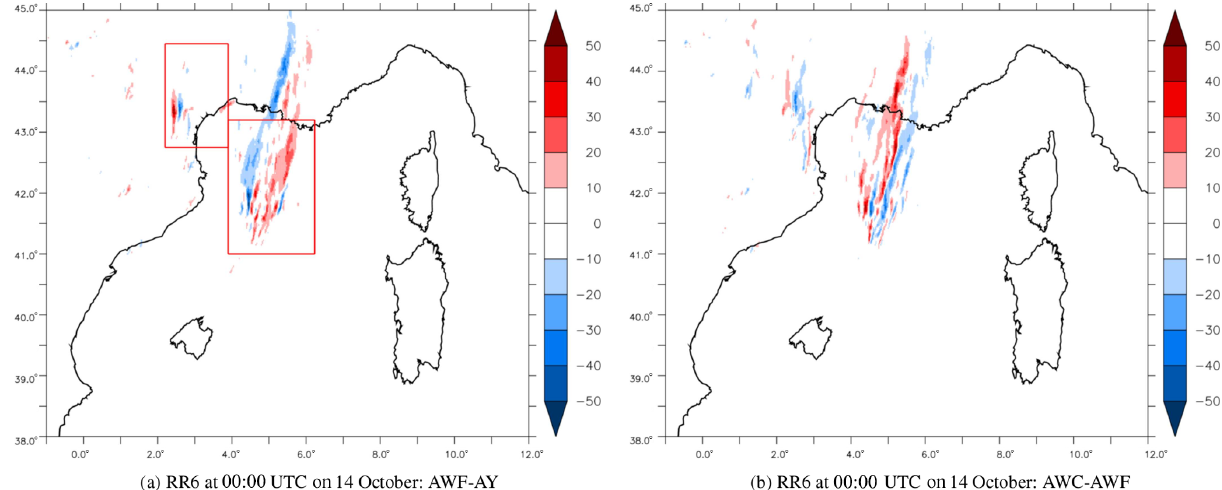
Figure 12. The 6h rainfall amount (mm) differences at 00:00UTC on 14 October between AWF–AY (a) and AWC–AWF (b)